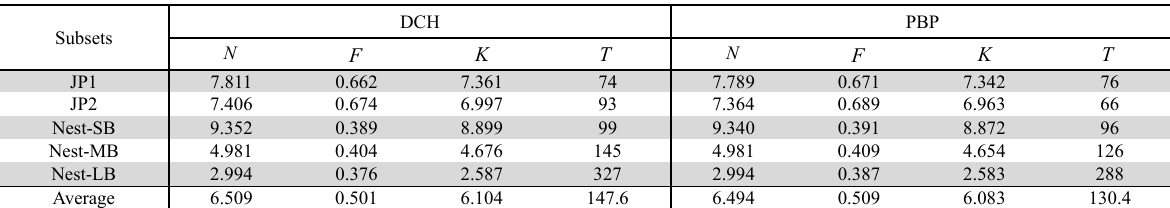
Comparison between the PBP and DCH